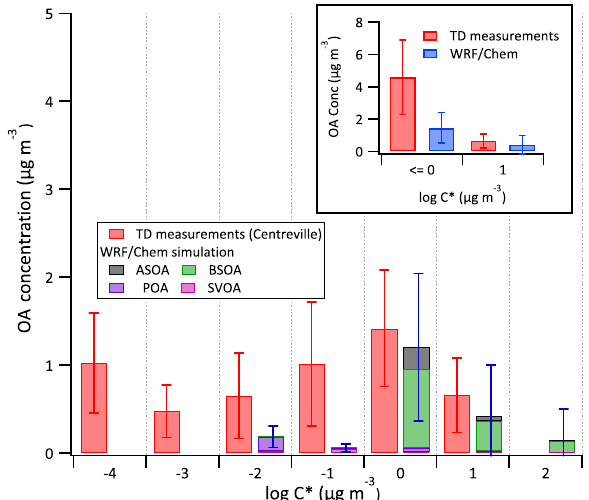
Figure 10. Comparison between measured OA volatility distribu- tions and those simulated in WRF/Chem over the Centreville re- gion. Bar height is mean and error bar is ± 1 standard deviation of distributions extracted from measurements and simulations for June 2013. The inset shows a two-bin comparison (bin 1: C ∗ ≤ 1µgm − 3 and bin 2: C ∗ = 10µg m − 3 ) . Simulated OA components include ASOA (anthropogenic-SOA), BSOA (biogenic-SOA), POA (primary-OA), and SVOA (semivolatile OA formed via oxidation of evaporated